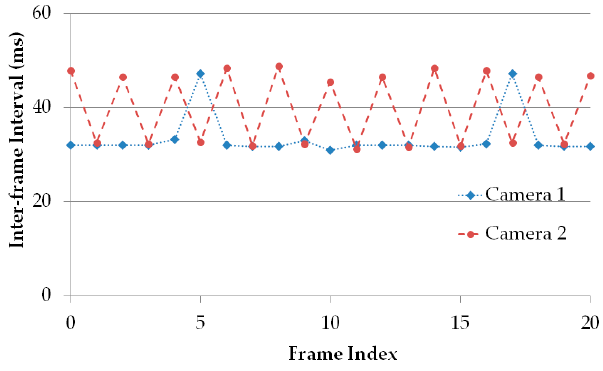
Figure 3. Experimental records of cameras’ frame rate variation by measuring inter-frame intervals.